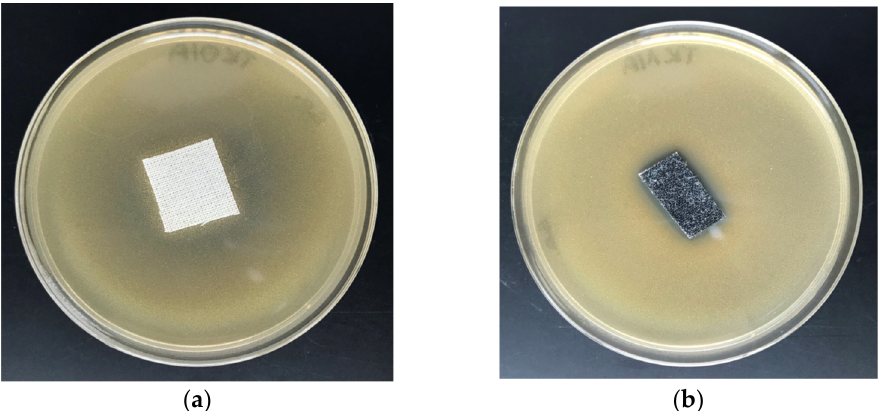
Figure 5. Tests of antimicrobial activity of COT–Zn (0) composites against E. coli. Inhibition zones of bacterial growth in Petri dishes: ( a ) COT; ( b ) COT–Zn-10 (1 s/2 s).